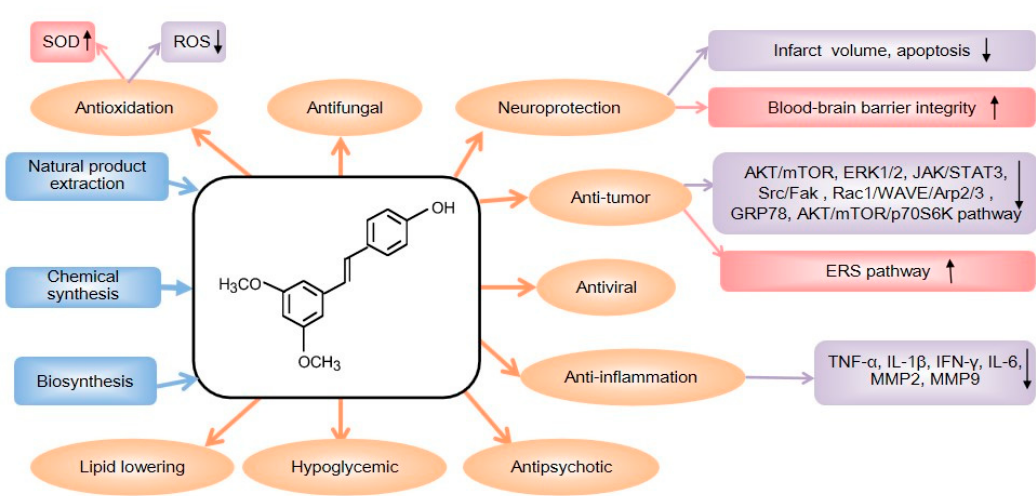
Figure 2. Bioactivities and possible mechanisms of pterostilbene. The anti-tumor mechanism of pterostilbene is related to several tumor characteristics, including anti-proliferation (AKT/mTOR, ERK1/2 and JAK/STAT3 pathway), the induction of apoptosis (AKT/mTOR/p70S6K and ERS pathway), the inhibition of invasion and metastasis (Src/Fak and Rac1/WAVE/Arp2/3 pathway), and the inhibition of tumor stem cells (GRP78 pathway). AKT, active human protein kinase; mTOR, mammalian target of rapamycin; ERK1/2, extracellular signal-regulated kinase; JAK/STAT3, Janus kinase/signal transducer and activator of transcription; p70S6K, downstream of mTOR; ERS, endoplasmic reticulum stress; Src/Fak, steroid receptor coactivator/focal adhesion kinase; Rac1, Rac family small GTPase 1; WAVE, WASP-family verprolin-homologous protein; Arp2/3, actin-related protein 2/3; GRP78, glucose-regulated protein; SOD, superoxide dismutase; ROS, reactive oxygen species; TNF- α , tumor necrosis factor- α ; IL-1 β , interleukin-1 β ; IFN- γ , interferon- γ ; IL-6, interleukin-6; MMP2, matrix metalloprotein-2; MMP9, matrix metalloprotein-9.